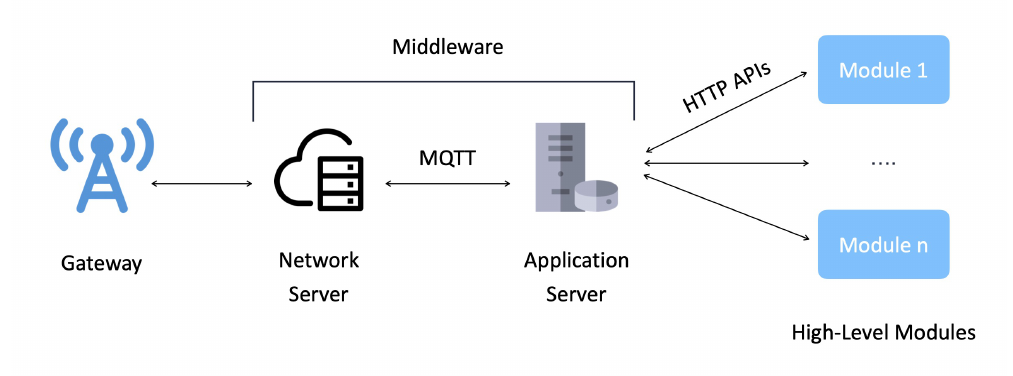
Figure 9. The LoRaFarM middleware layer connects farm modules with high-layer